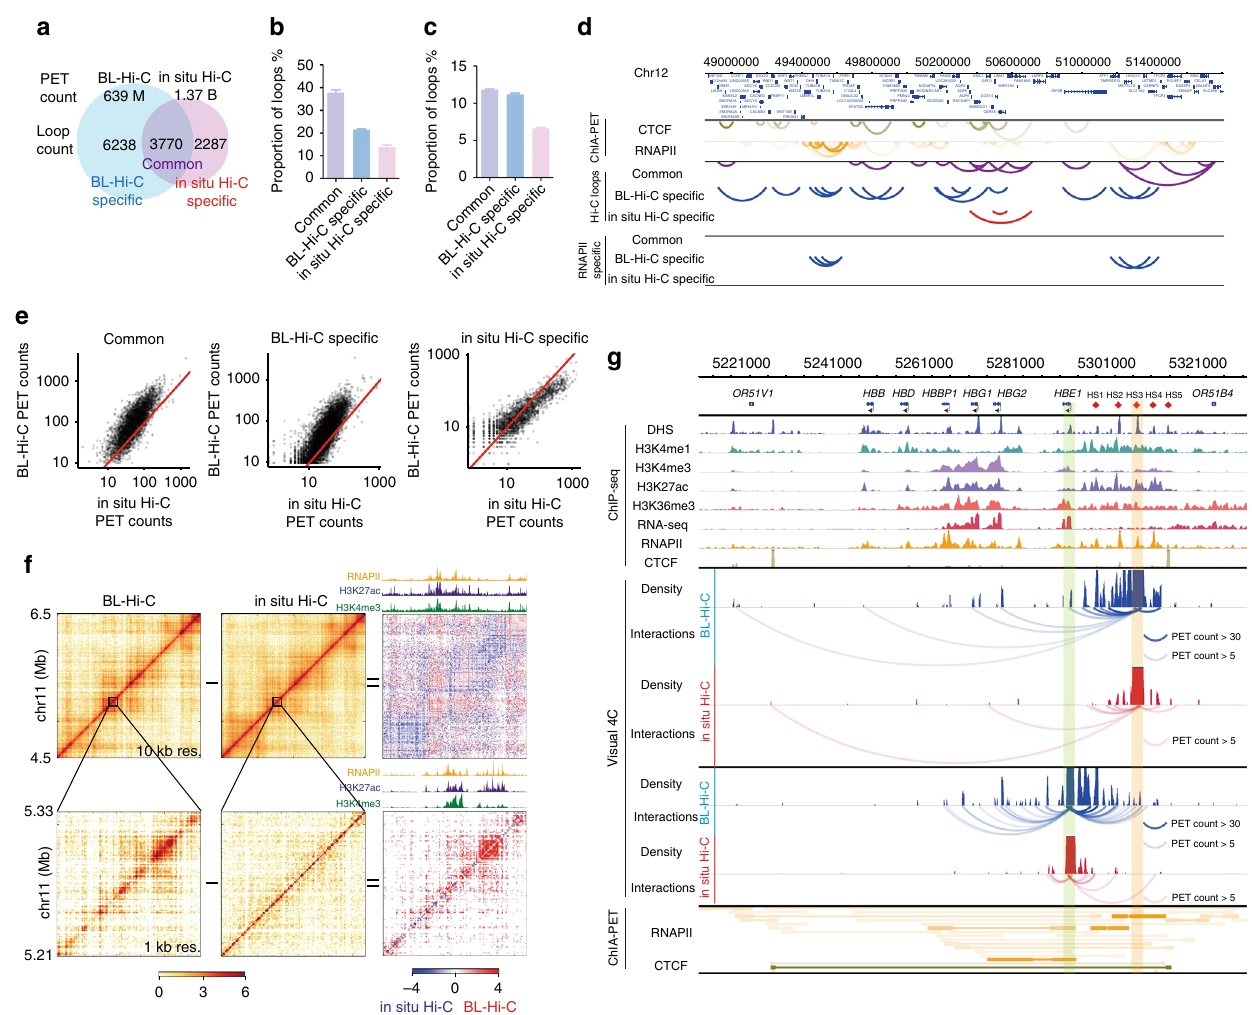
Fig. 3 BL-Hi-C targets functional and active chromatin conformations. a The chromatin loops are determined by combined data sets from BL-Hi-C (blue) and in situ Hi-C (Rao et al., purple). Common loops share paired anchors in the two methods, and others are BL-Hi-C-speci fi c or in situ Hi-C (Rao et al .)- speci fi c loops. The PET count indicates sequencing depth. b , c The percentages of common loops and speci fi c loops that are consistent with the public ChIA-PET loops of CTCF and RNAPII. d Comparison of ChIA-PET loops and Hi-C loops in a typical region, chromosome 12. e The normalized PET counts of the loops identi fi ed by BL-Hi-C and in situ Hi-C (Rao et al.). The red line indicates equal counts. f The normalized interaction heatmaps of BL-Hi-C (left), in situ Hi-C (Rao et al., middle), and the difference (right) at 10 kb resolution (up) and 1 kb resolution (down) of chromosome 11, including β -globin region. g Visual 4C of β -globin region. A diamond indicates a viewpoint. All the Hi-C interactions with this viewpoint are accumulated into peaks along the genome and connected by arcs. The bold arcs refer to high PET cluster